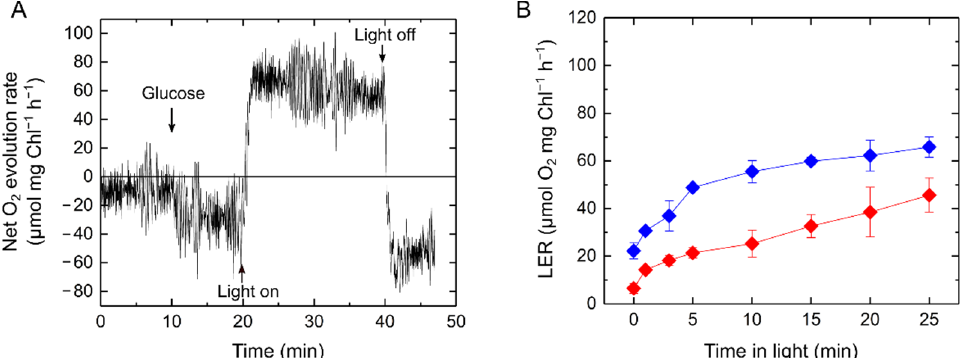
Figure 7. Effects of exogenously added glucose on light-enhanced respiration (LER) in Synechocystis sp. PCC 6803 adapted to the darkness for 24 h ( A ). Representative data of net O 2 evolution rate in response to the illumination with a red actinic light (190 µmol photons m − 2 s − 1 ). Glucose (5 mM) was exogenously added 10 min before the start of the illumination as indicated by a black arrow ( B ). LER at different illumination times in the absence (red) and presence (blue) of glucose. Data are shown as the mean with the standard deviation ( n = 3, biological replicates).